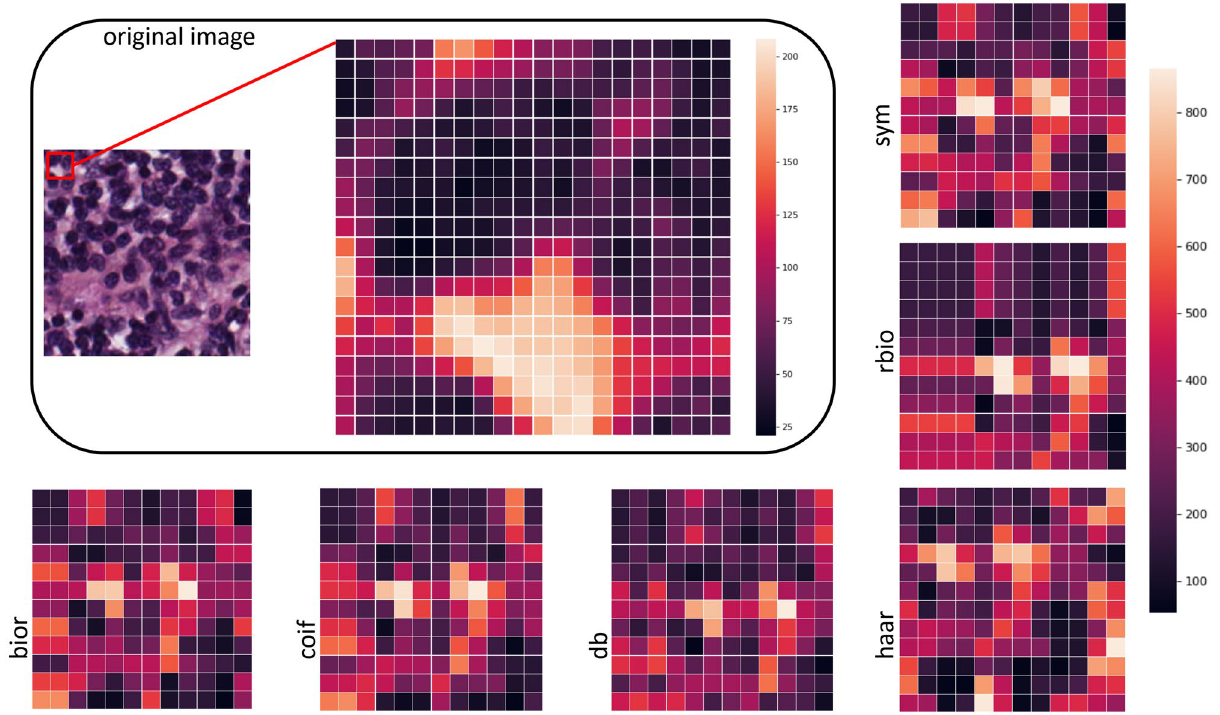
Figure 5. Differences among mother wavelets at the second level of decomposition for part (red bounding box) of the original image. db daubechies, sym symlets, coif coiflets, bior biorthogonal, rbio reverse biorthogonal. (Figure created in PowerPoint 2013, https:// www. micro soft. com/ micro soft- 365/ power